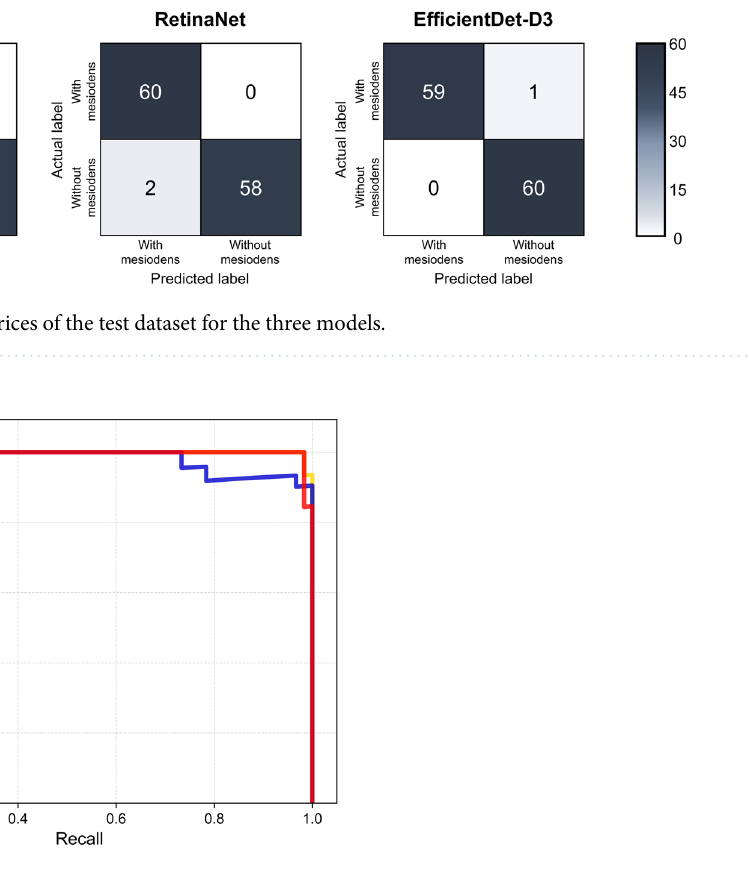
Figure 6. Precision-recall curves of the test dataset for the three